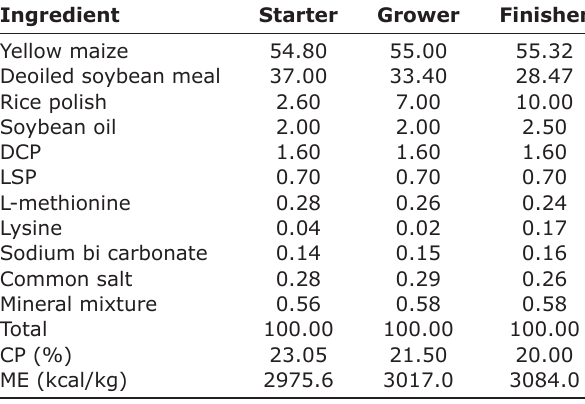
Table-1: Composition of broiler starter, grower and finisher diet (on % DM basis). Ingredient Starter